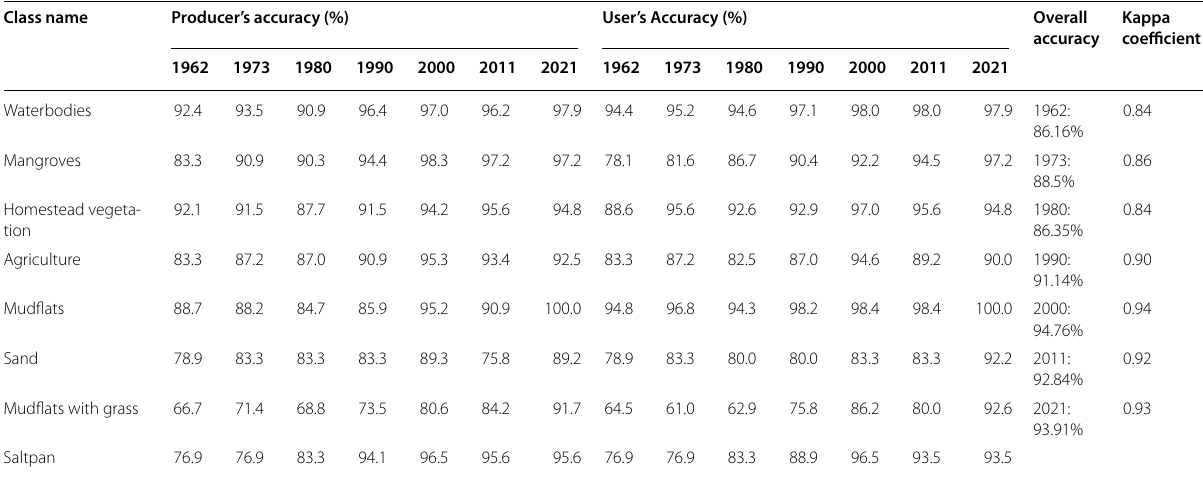
Table 8 Accuracy assessment for the land use and land cover classification for 7 classification years for the Bangladesh